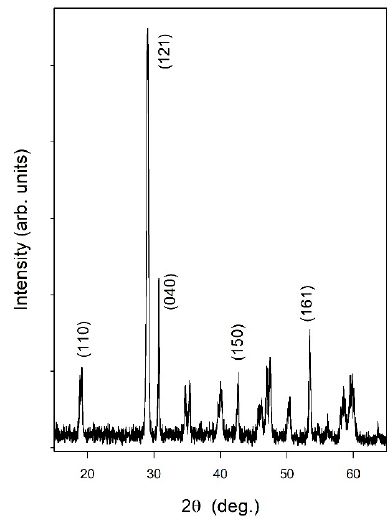
Figure 6. XRD spectrum of BiVO 4.